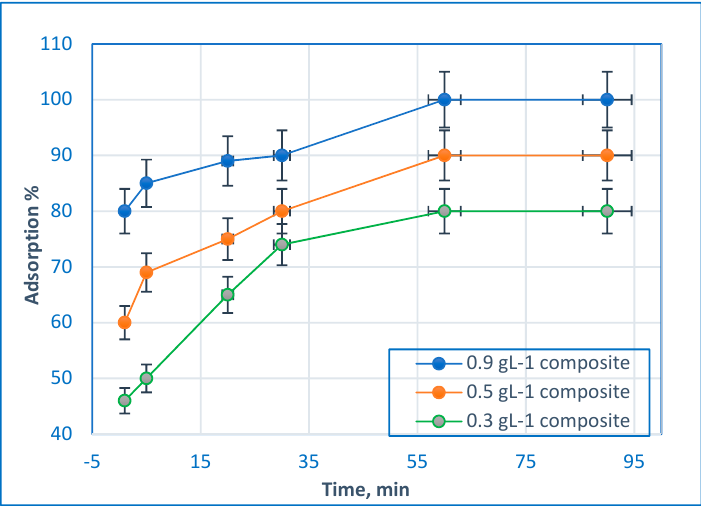
Figure 8. Effect of the adsorbent dosage of Hap/CS nanocomposite on BG dye removal.